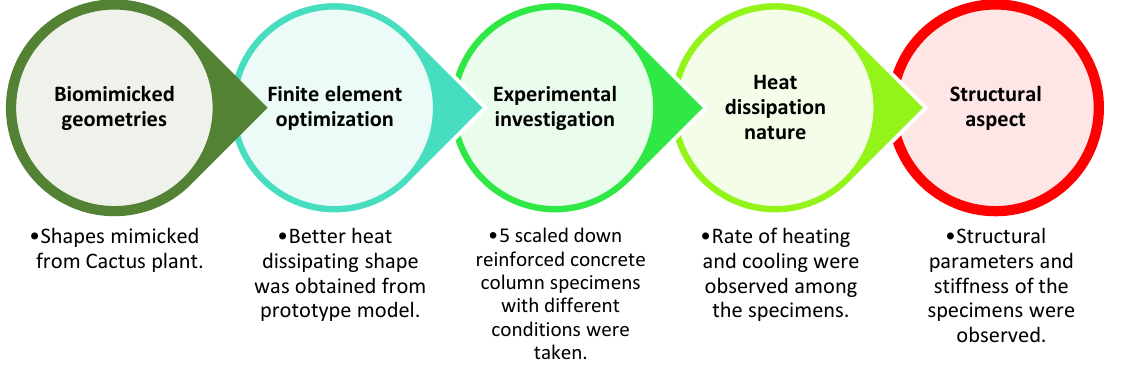
Structural aspect